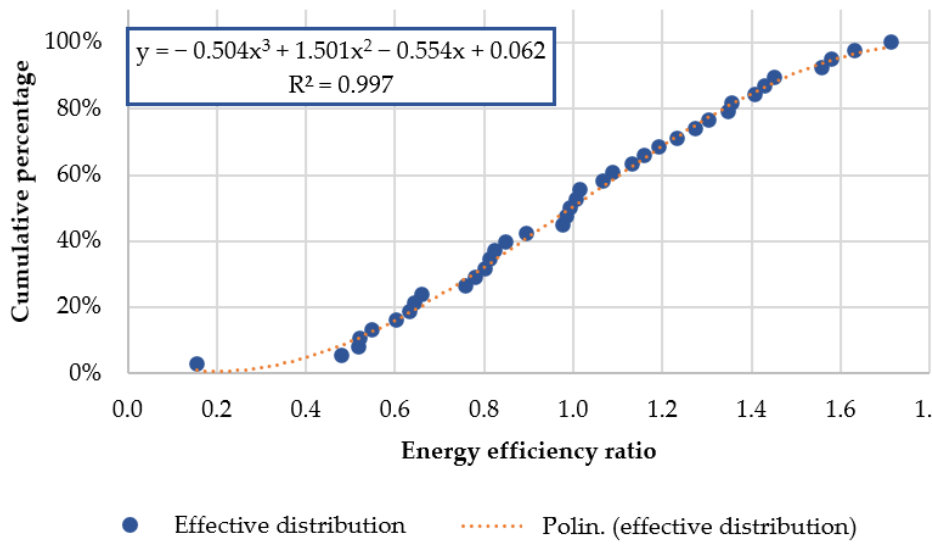
Figure 4. Distribution of the energy efficiency ratios.